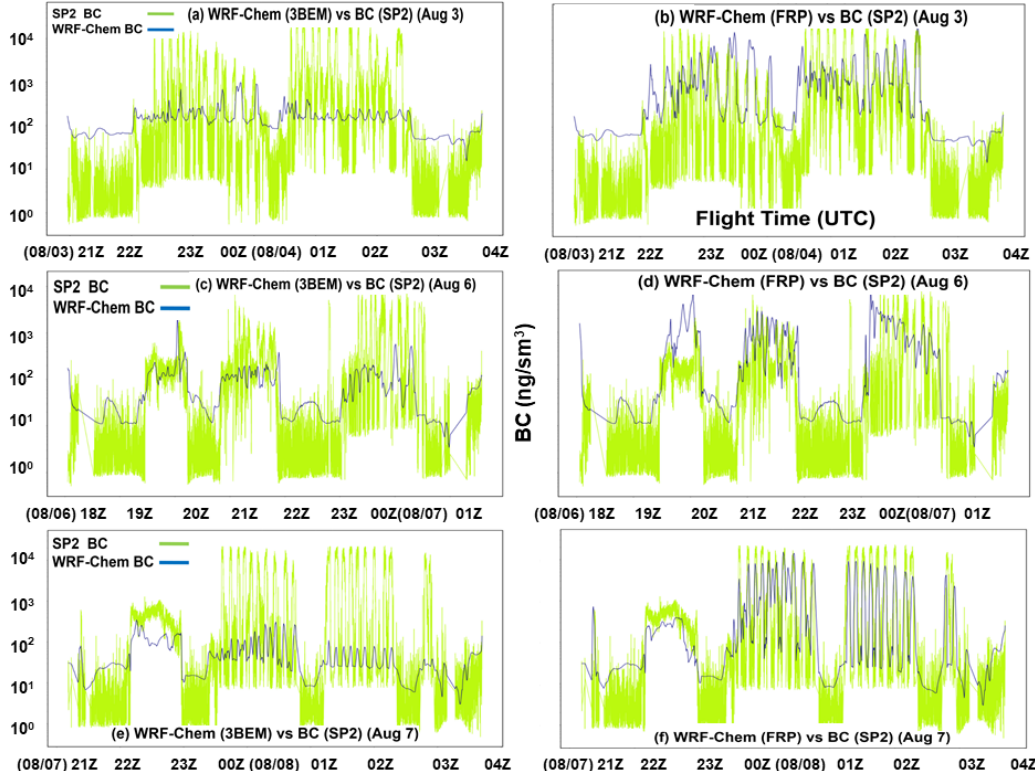
Figure 5. Time series for BC (SP2) in situ measurements and corresponding WRF-Chem-simulated BC (3BEM and FRP versions) for the 3 August (a, b) , 6 August (c, d) , and 7 August (e, f) DC-8 science